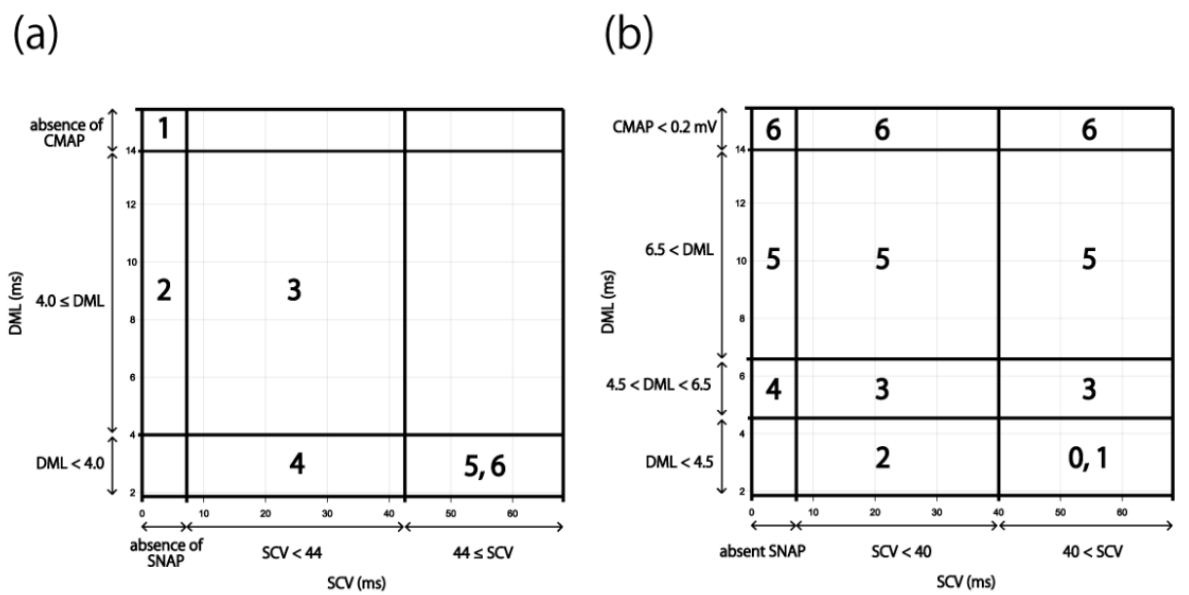
Figure 1. Electrophysiological severity classifications for CTS. ( a ) Padua classification. 1. Extreme